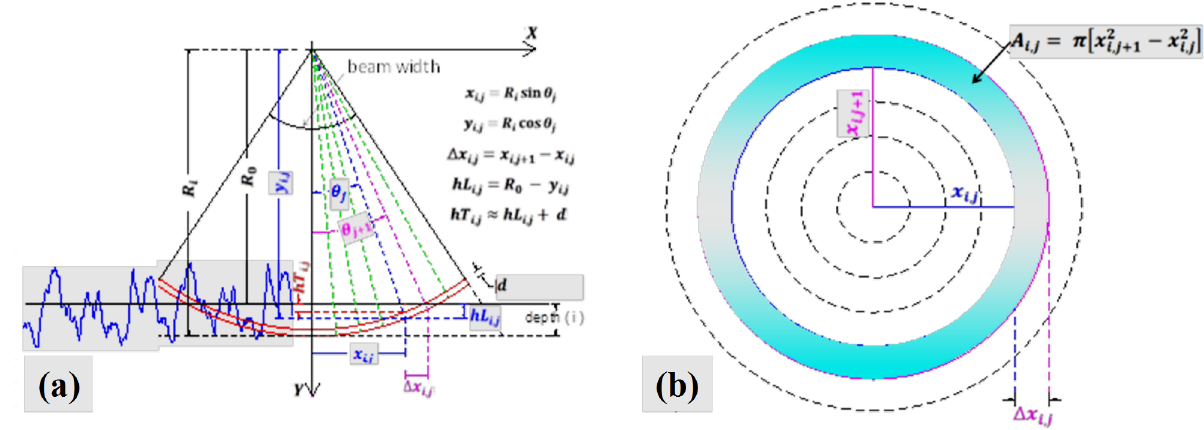
Figure 2. Schematic simulation procedure for altimeter waveform: ( a ) cross section; ( b ) plan view.